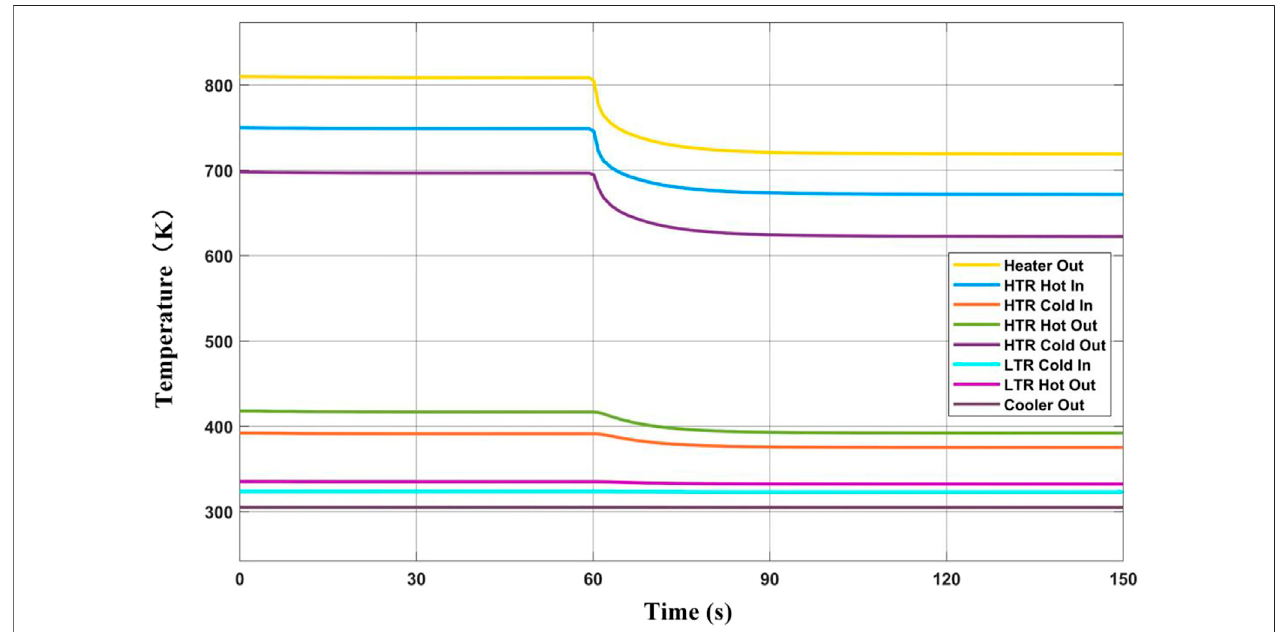
FIGURE 3 | Dynamic response of cycle temperature while reducing heat source